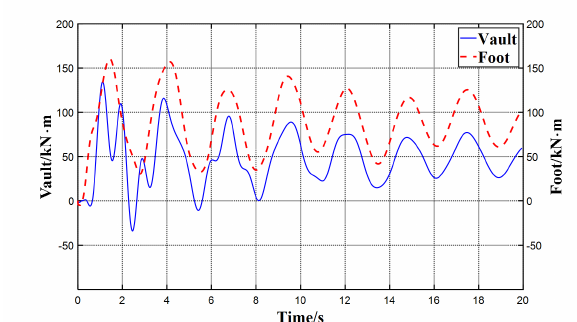
Fig. 14. Bending moment under lateral seismic